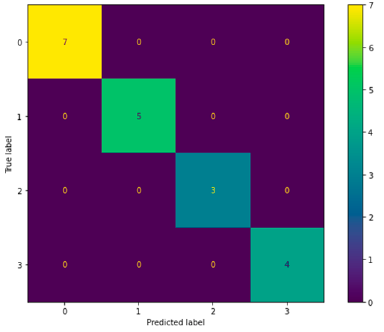
freshness classification.